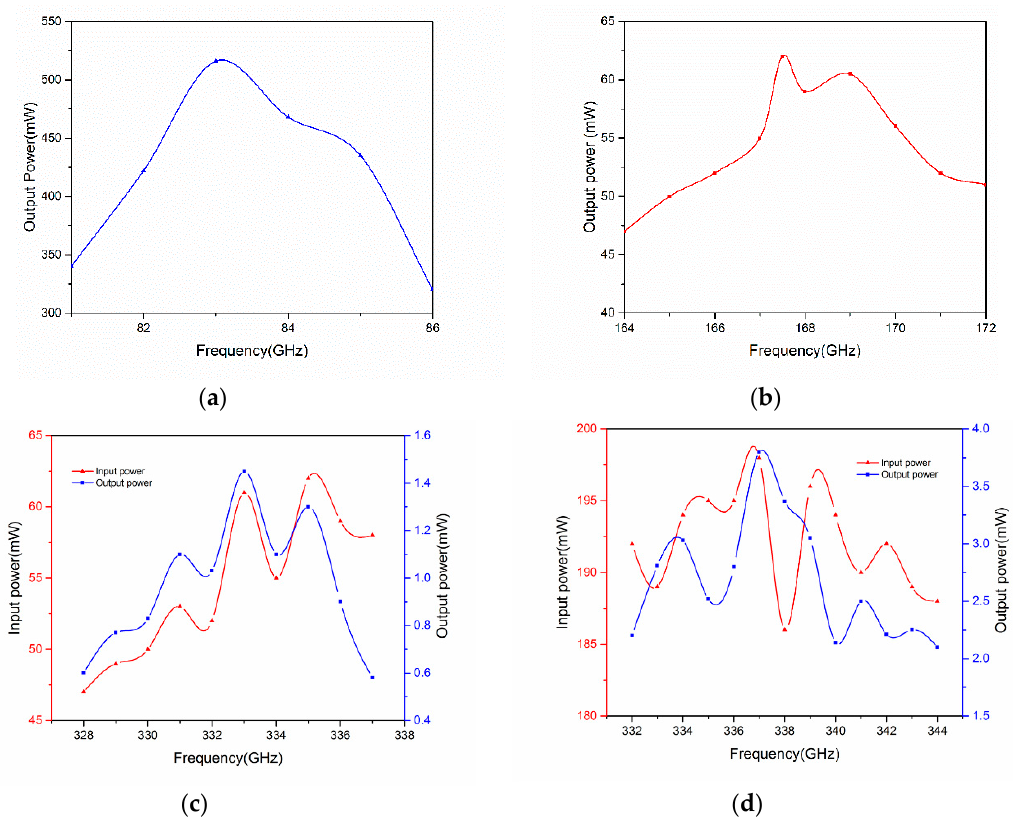
Figure 9. ( a ) Measured output power of the W-band source. ( b ) Measured output power of the 167 GHz high-power source. ( c ) Measured input and output power of the 335 GHz source based on a two-stage doubler. ( d ) Measured input and output power of the 335 GHz source based on a single-stage quadrupler. Table 1. Performance comparison of the doubler around 170 GHz.